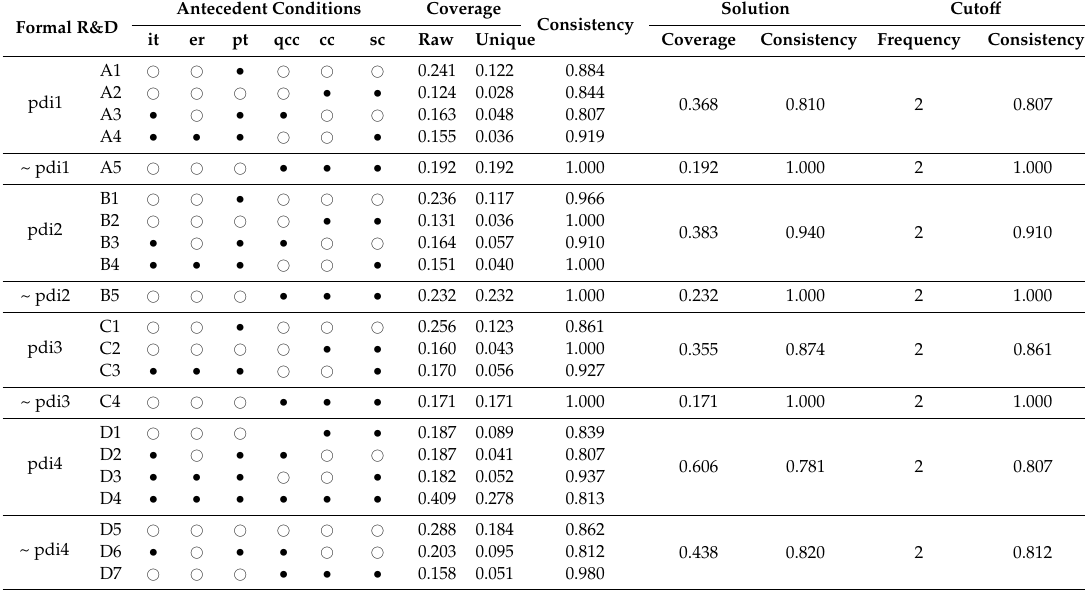
Table7. Configurationsofinternalhumanresourcemanagementpracticeandsupplychaincollaboration in formal R&D